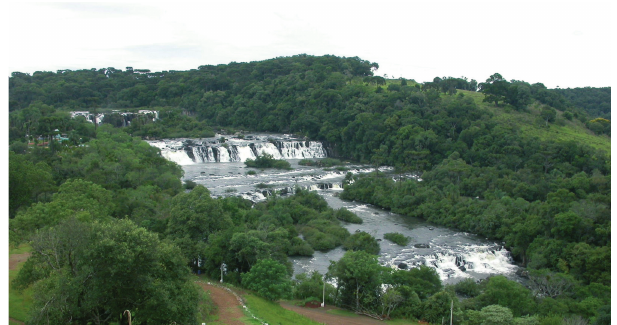
Fig. 9 . Rio Chapecó, at Abelardo Luz, Santa Catarina. The speci- mens of C. empheres were collected above the